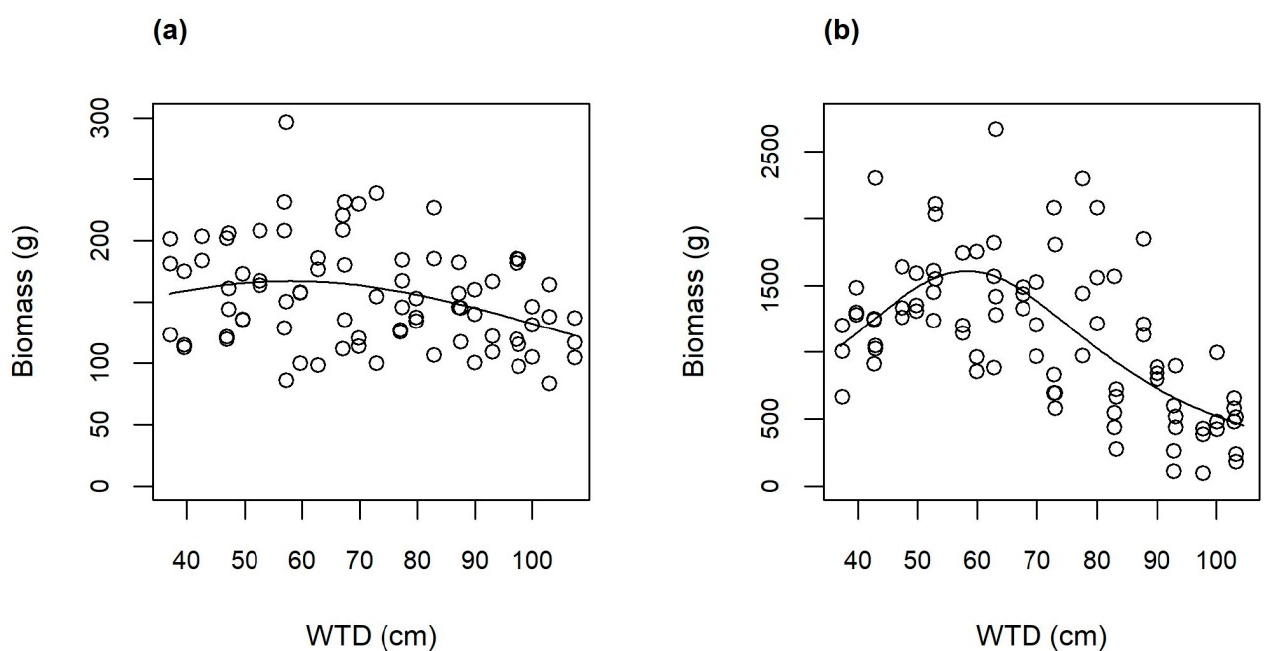
Figure 4. Living aboveground biomass (dry mass) per plant of cup plant, harvested ( a ): at the end of the first growing season (August 2018) and ( b ): at the end of the second growing season (September 2019) depending on water table distance (WTD). GLM: Gamma-distributed residuals, square function, ( a ): p = 0.007, n = 82; ( b ): p < 0.001, n = 84.